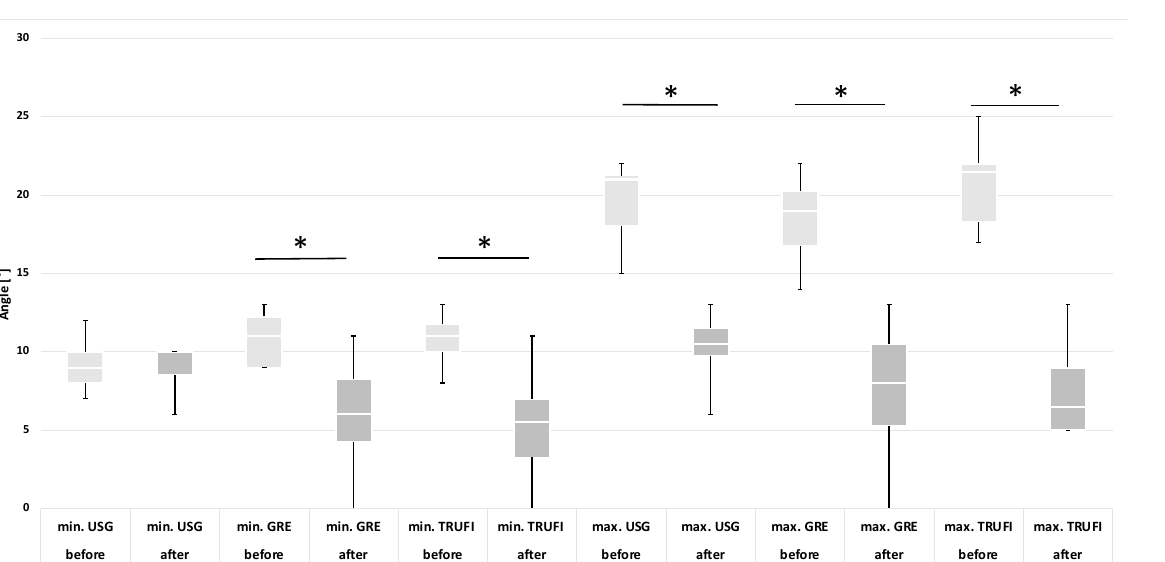
Figure 5. The minimum and maximum values of glottic angles in patients without changes in the mobility VF after surgery in relation to the preoperative examination with the use of US and MRI sequences (GRE and TRUFI).